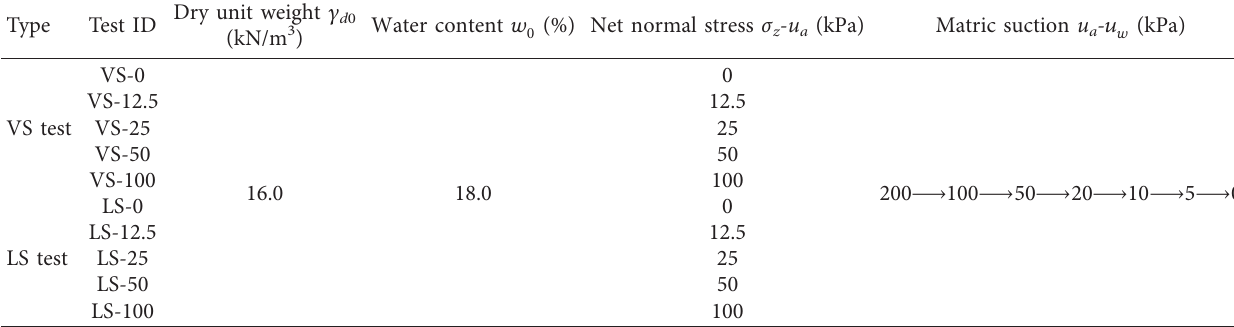
Table 2: Summary of testing program